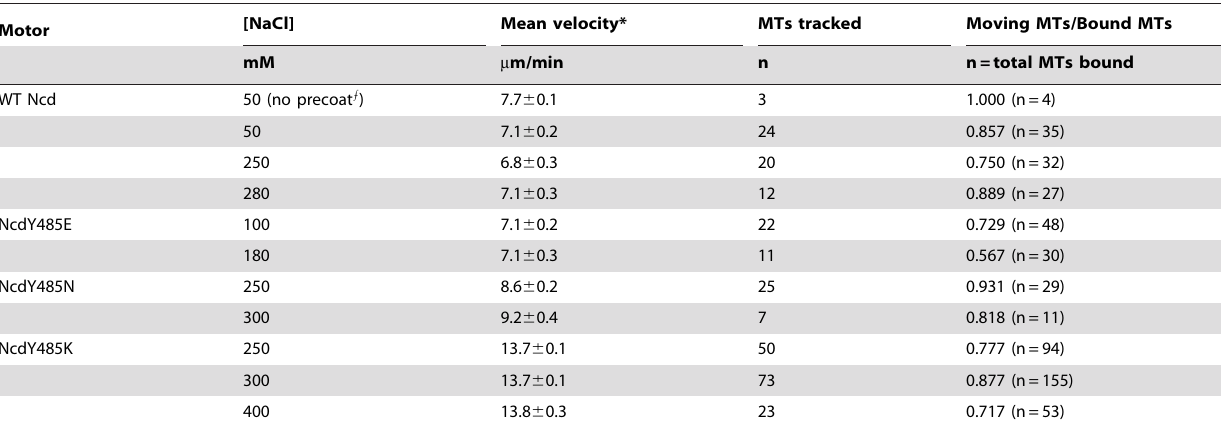
Table 2. NcdY485 mutant motility.